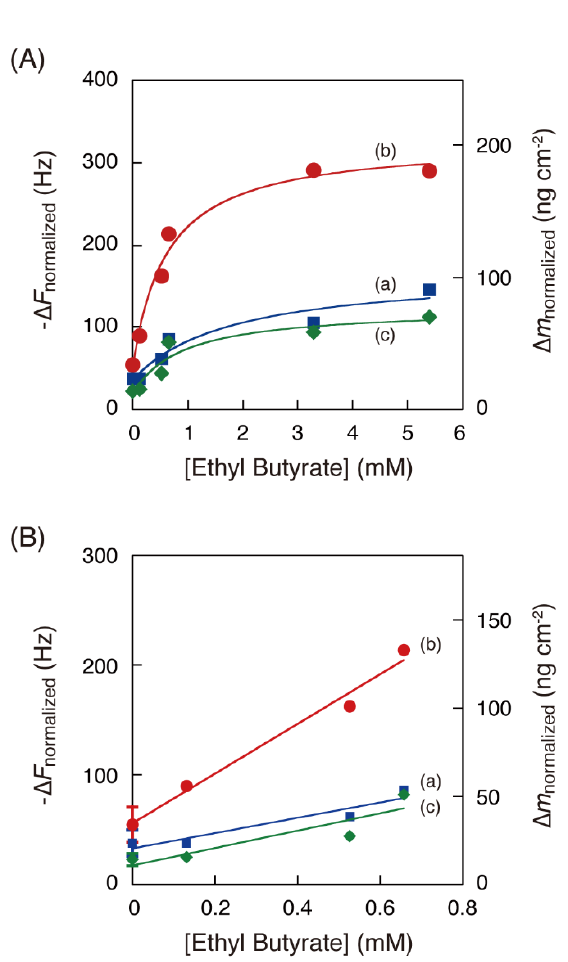
Figure 5. ( A ) Saturation curves for the adsorption of ethyl butyrate on (a: square) α‐ , (b: circle) β‐ , and (c: diamond) γ‐ CD films, as a function of concentration. ( B ) Linear approximation in the range of 0–0.66 mmol L − 1 ethyl butyrate. The error bars at the origin indicate the standard deviation. The Δ F values were normalized to a film amount of 3000 ng cm − 2 .